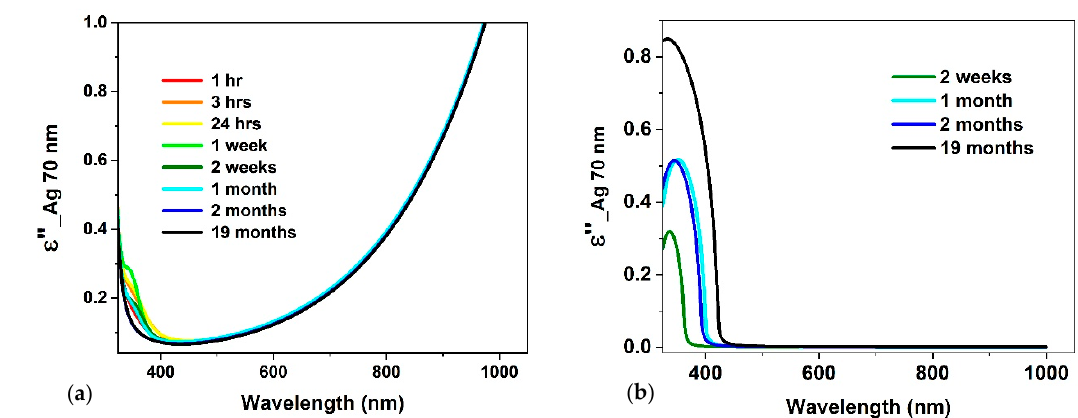
Figure 11. Dielectric permittivity imaginary part evolution for the 70 nm Ag thin films: ( a ) main layer; ( b ) roughness layer in the range of 330–1000 nm.